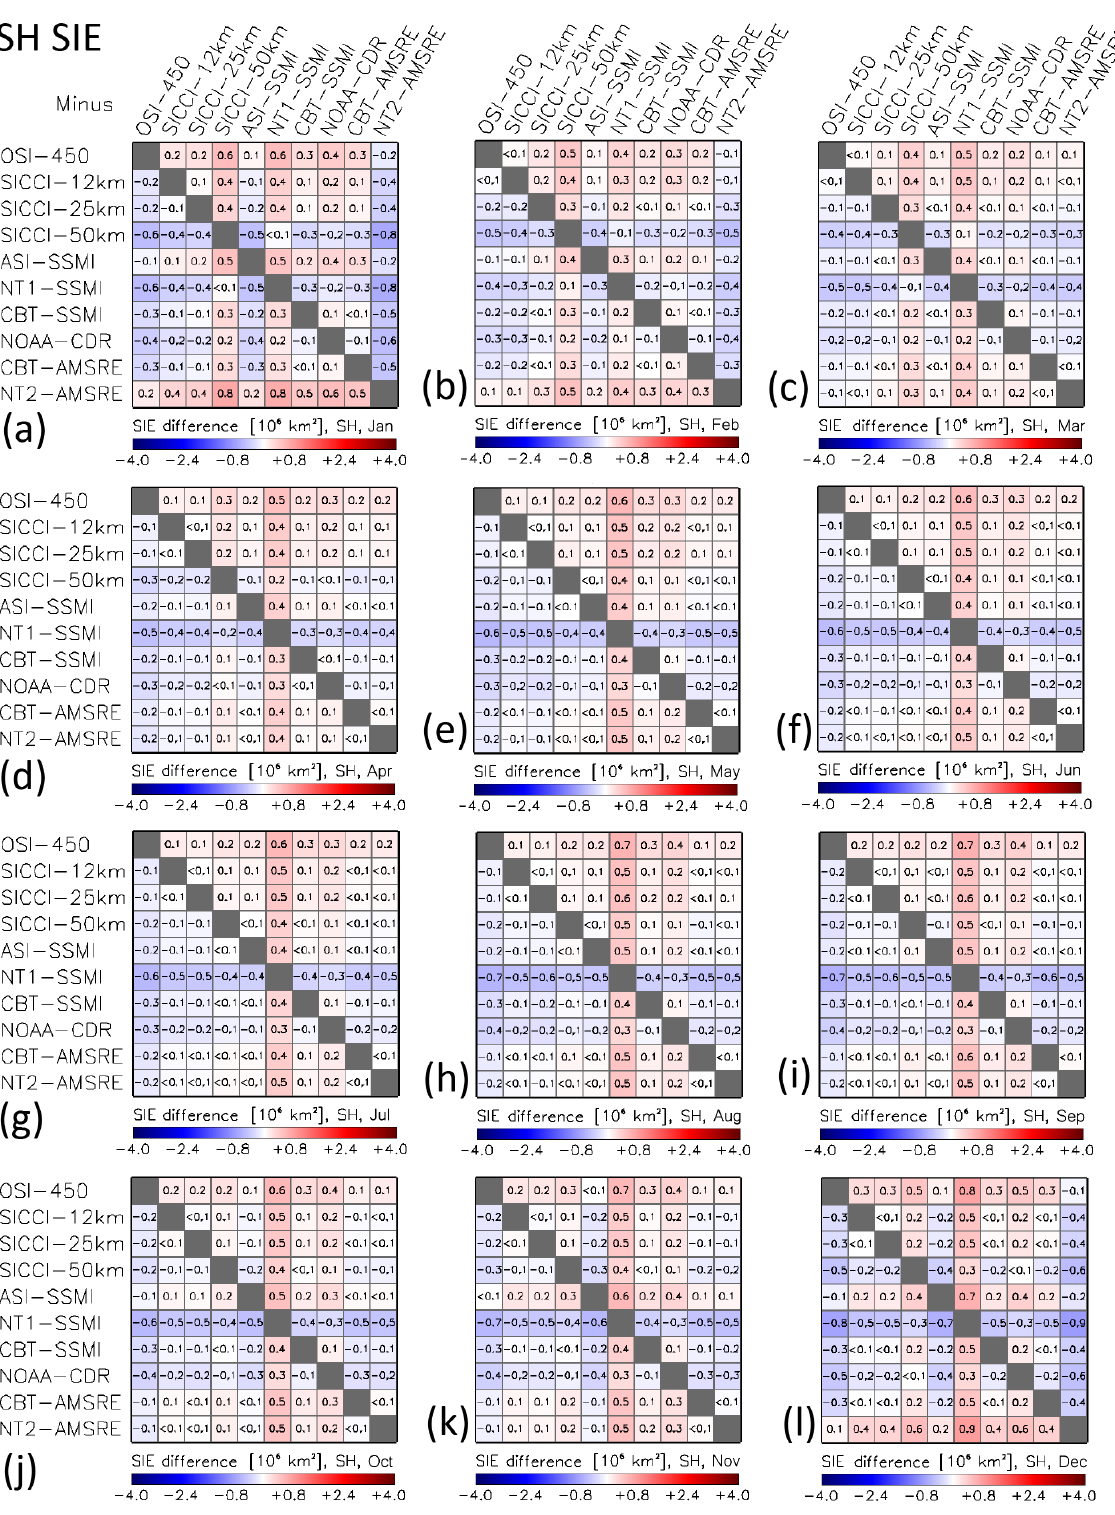
Figure G6. As Fig. G3 but for the Antarctic. Note the larger range of the SIE differences compared to the Arctic.